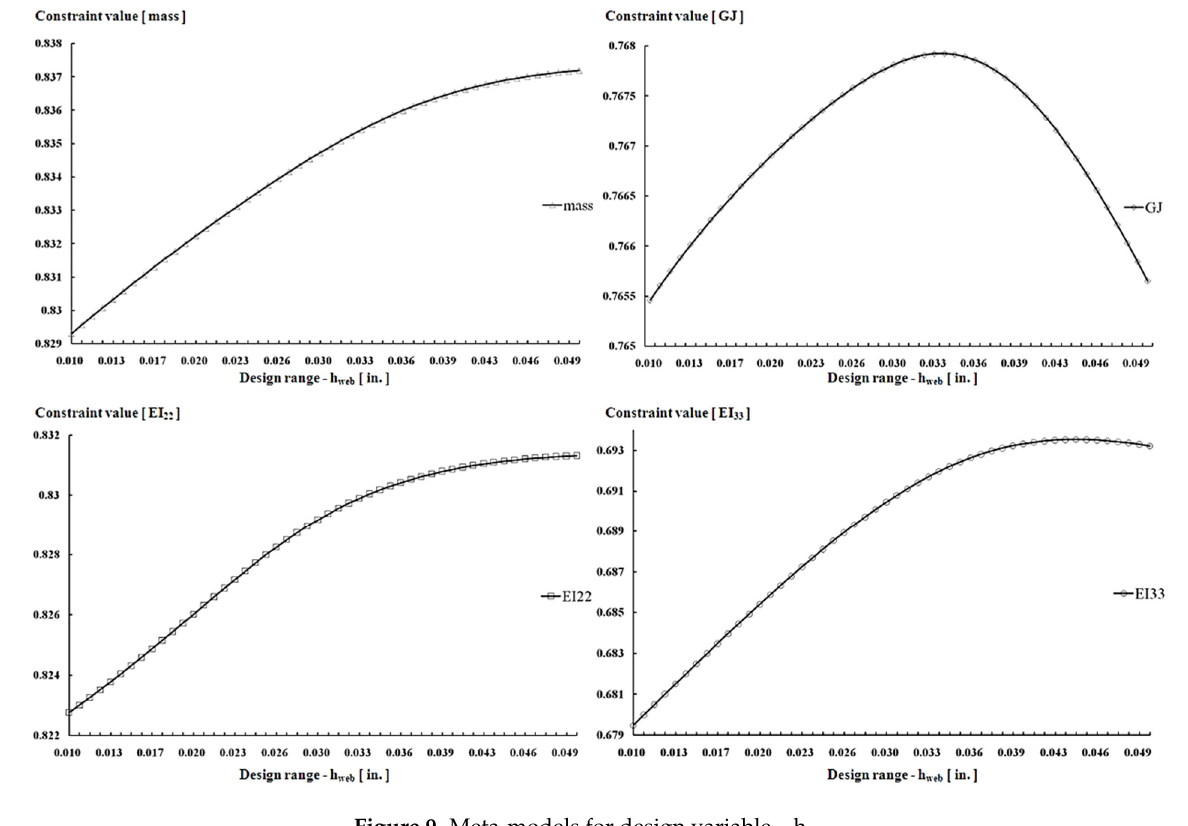
Figure 9. Meta-models for design variable—h web .